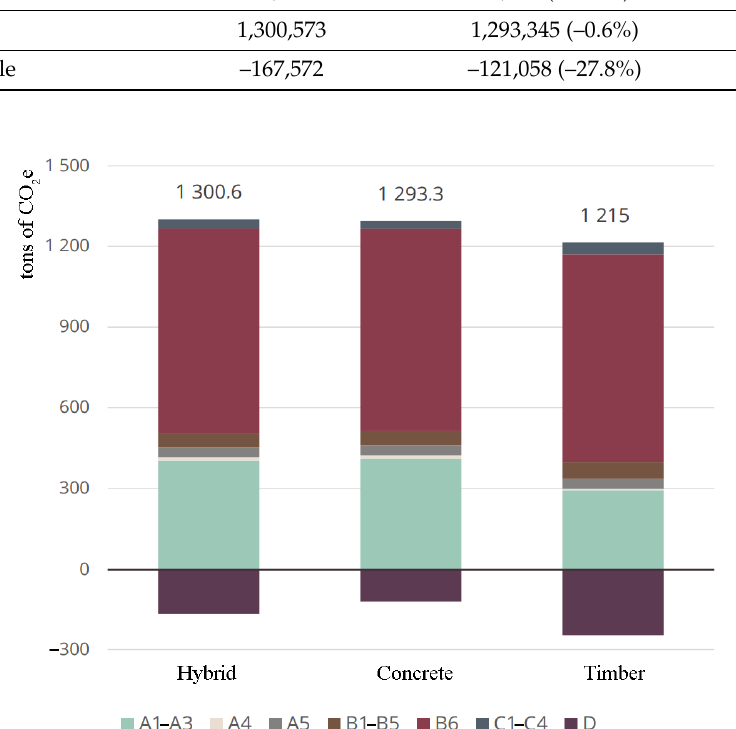
Figure 10. Results of the carbon footprint comparison as a bar chart.